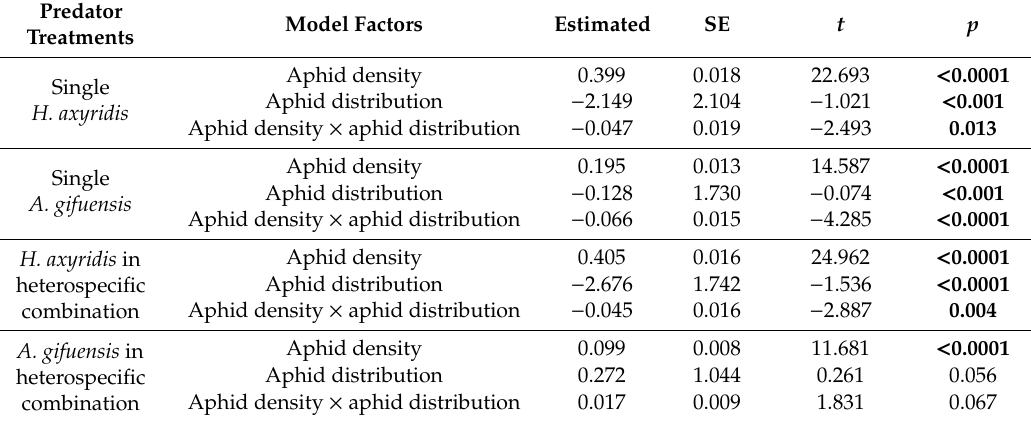
Table 2. Generalized linear mixed model (GLMM) testing the e ff ects of fixed factors on the number of aphids consumed / parasitized by single Harmonia axyridis or Aphidius gifuensis , individual H. axyridis or A. gifuensis in heterospecific combination (n = 70 for each assay). Observation level factor (tested enemies) were included as random e ff ects. Seven levels of aphid density (4, 8, 16, 32, 64, 128, or 256 aphids per cage) were provided to each enemy